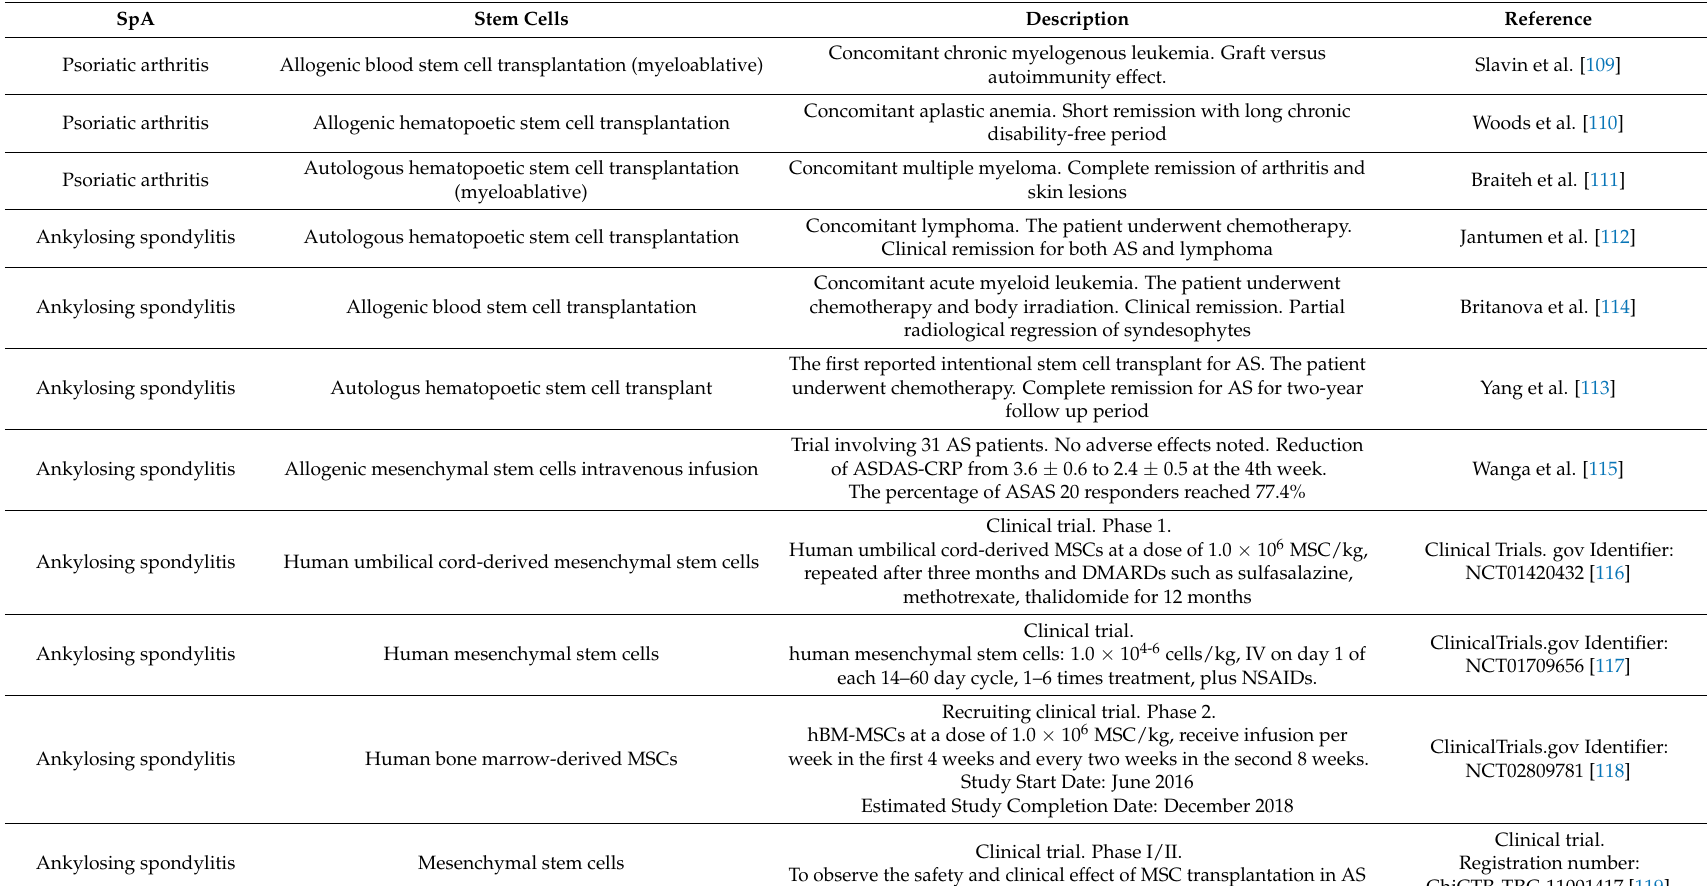
Table 2. Use of stem cells in patients with spondyloarthropathies in published literature and registered clinical